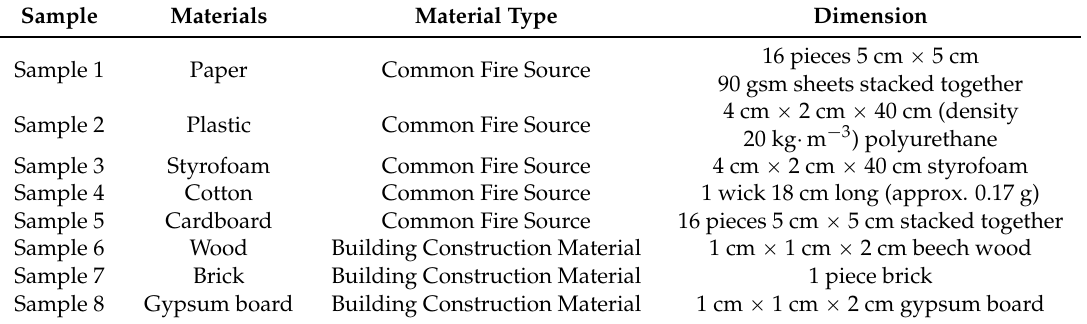
Table 1. The tested materials and its sample dimension prepared according to European